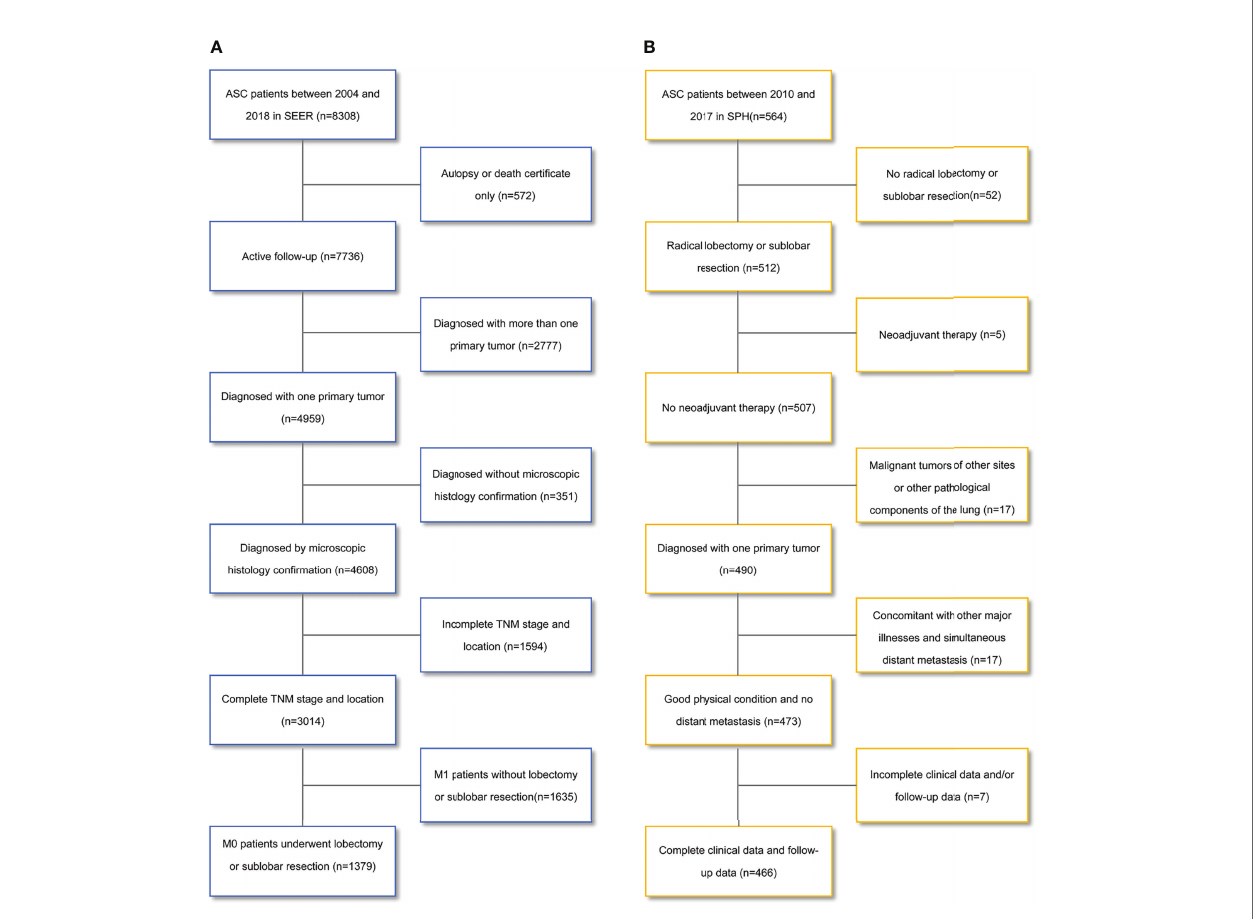
FIGURE 1 | Flowchart for patient selection. (A) the Surveillance, Epidemiology, and End Results database; (B) the Shanghai Pulmonary Hospital database. ASC, lung adenosquamous